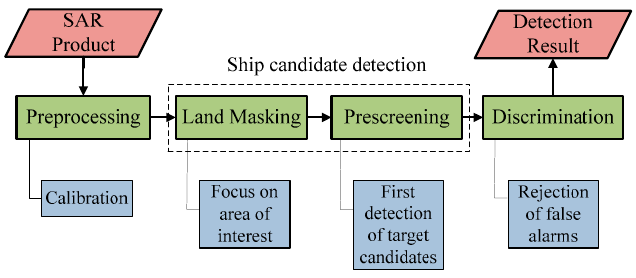
Figure 1. Overview of ship detection strategy.